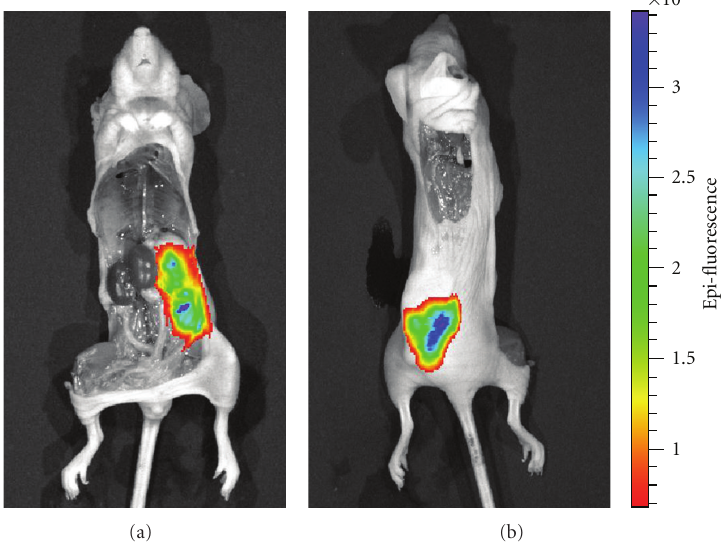
Figure 7: Whole mouse tumor imaging. (a) Ventral site where the tumor was exposed. (b) Dorsal site, tumor was underneath the skin. Other organs had negative signal, indicating AQD-Tn mAb prove was specific and sensitive to the